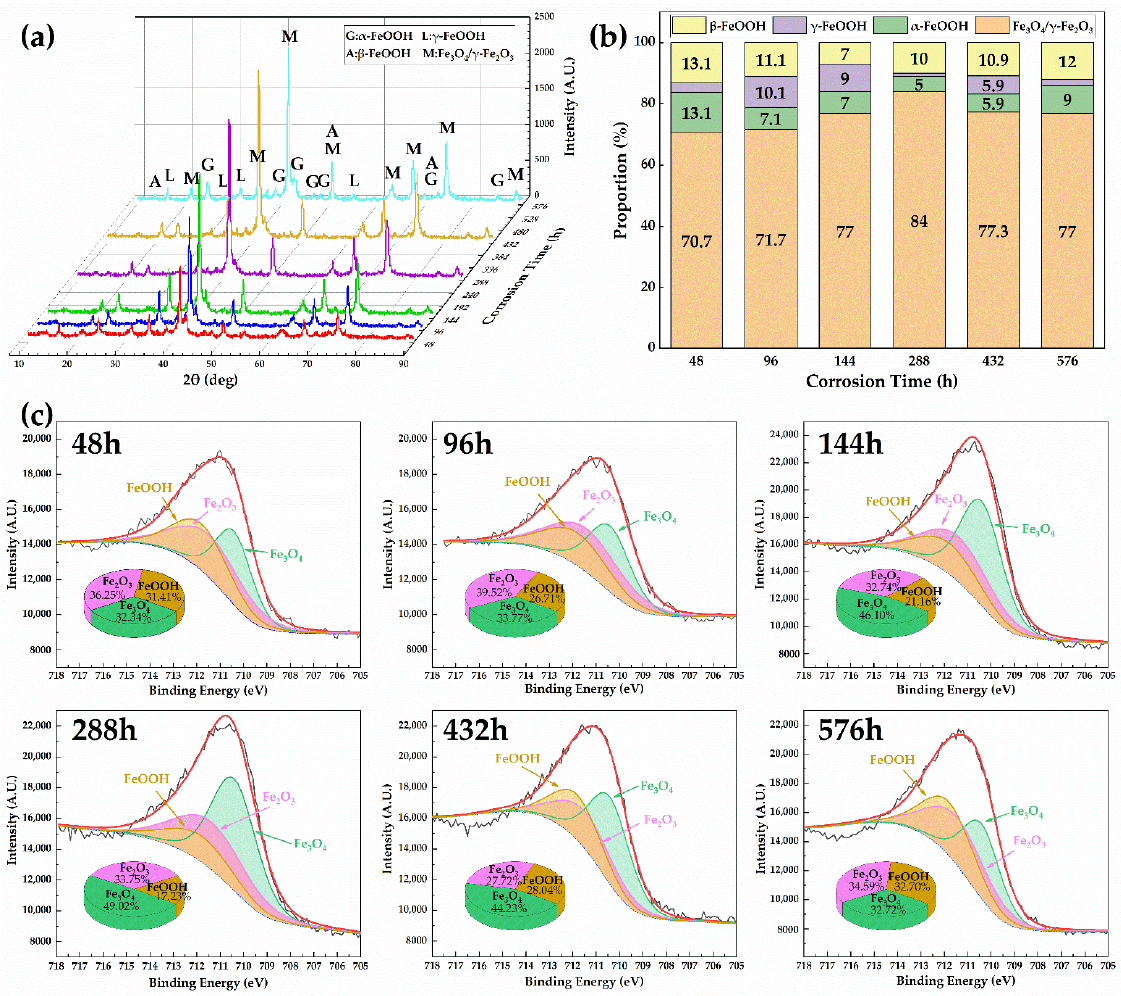
Figure 4. X-ray diffraction analysis of rust formed on surfaces of 30CrMnSiA steel: ( a ) phase compositions; ( b ) the relative proportion of each phase; ( c ) XPS spectra of Fe2p3/2 and the atomic percentage of each phase in the rust film for 48, 96, 144, 288, 432, and 576